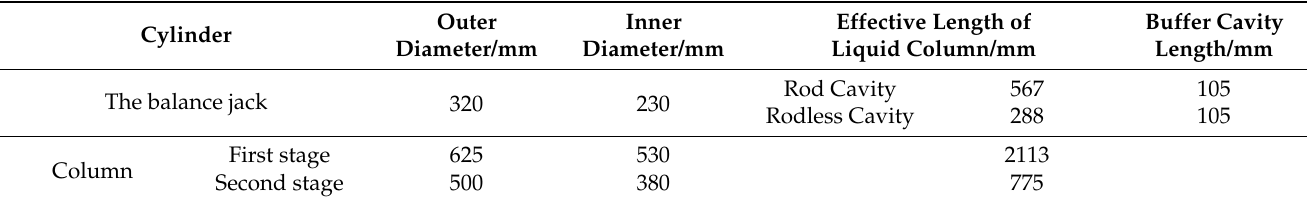
Table 1. Main parameters of column and the balance jack when the support height is 6.65 m.